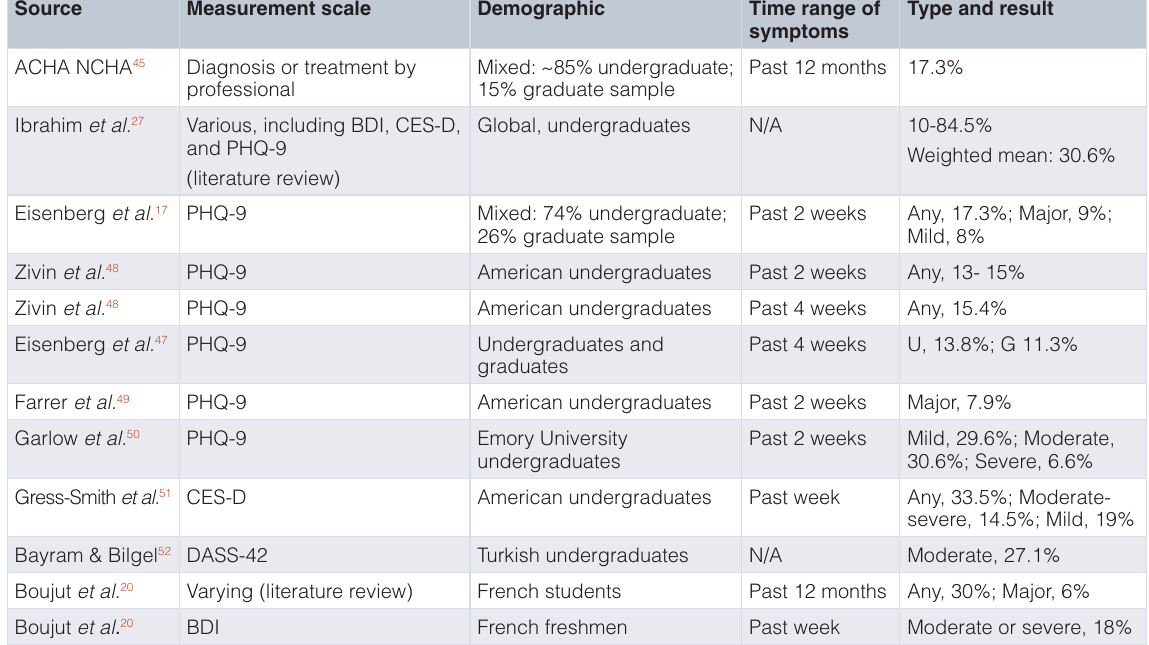
Table 3. Representative depression rates among undergraduate and other students. Please refer to Table 1 for abbreviations.